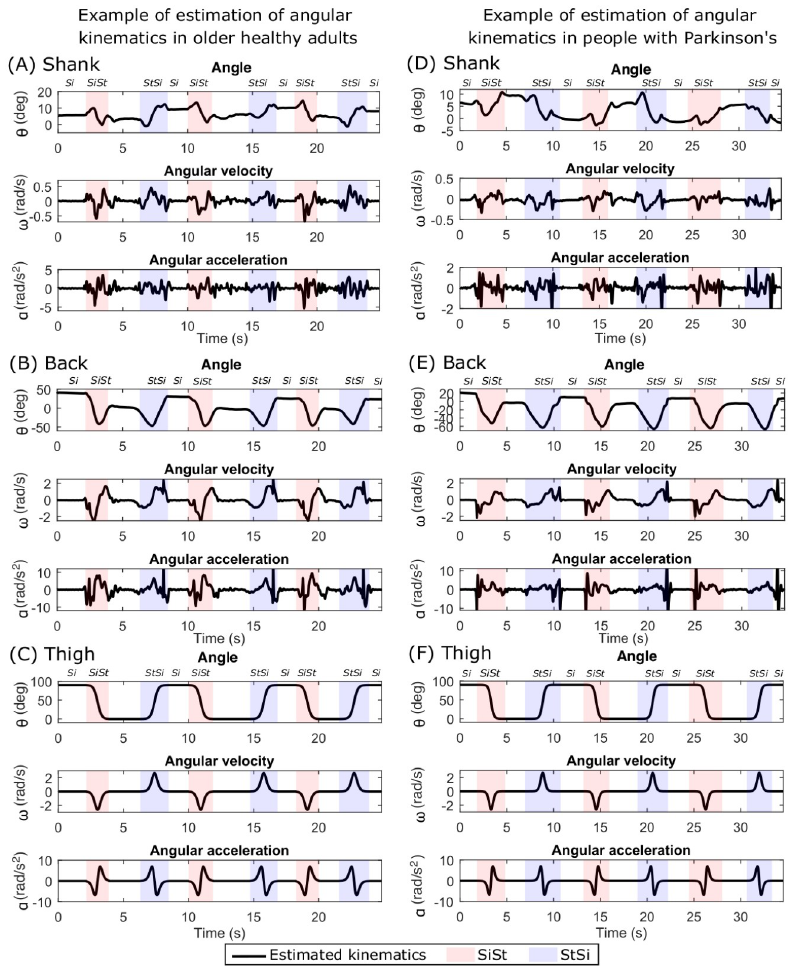
Fig 8. Estimated angular kinematics in older healthy adults (OH) and people with Parkinson’s (PwP). An example of estimated angular kinematics in OH participants (left column) is shown for (A) Shank, (B) Back and (C) Thigh. The segmentation of sit-to-stand, stand-to-sit, sit and stand (no label on the top) is also shown with different background colours and labels at the top. An example of estimated angular kinematics in PwP participants (right column) is shown for (D) Shank, (E) Back, and (F)